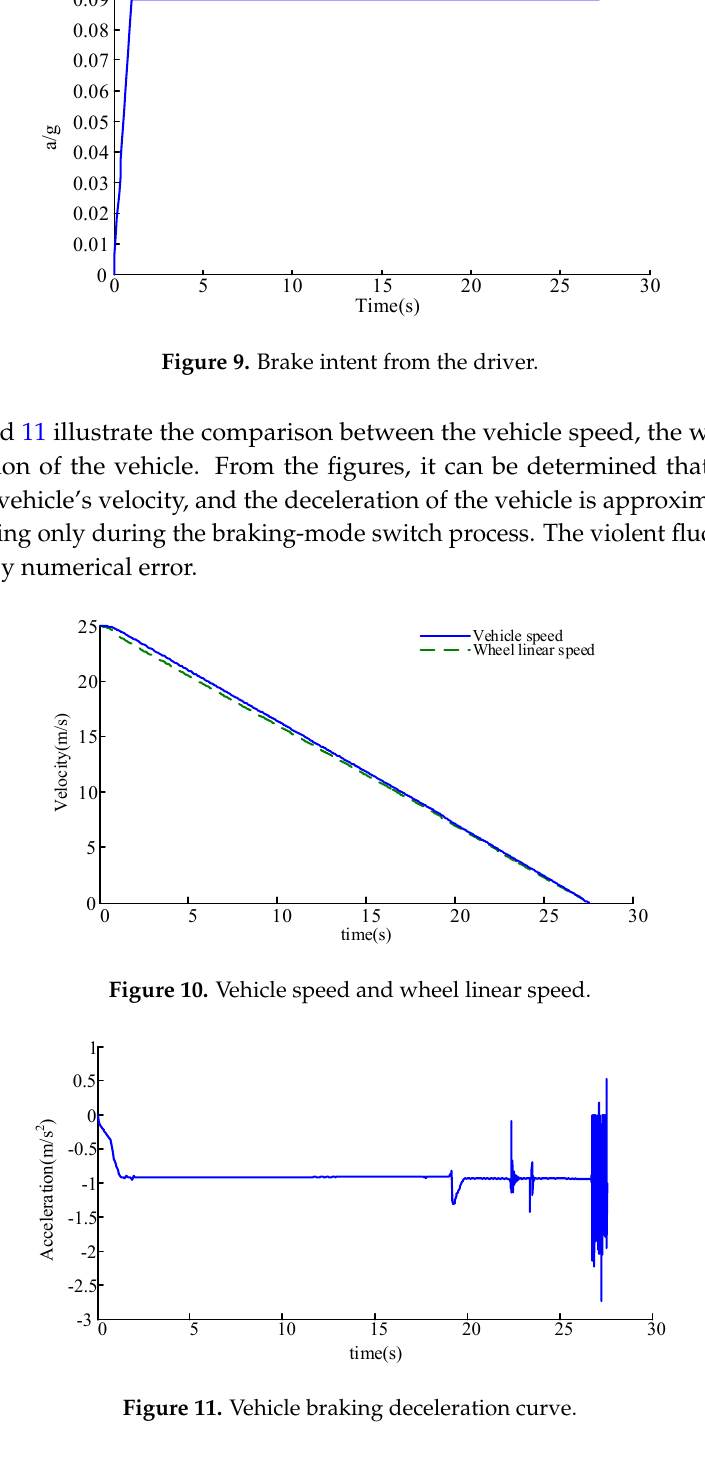
Figure 11. Vehicle braking deceleration curve.